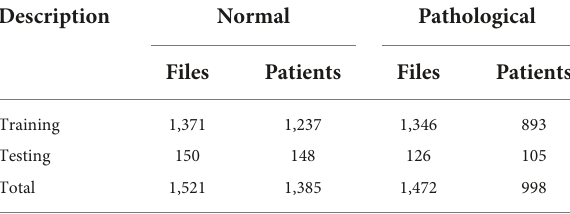
TABLE 1 Number of patients and files in TUH EEG Abnormal Corpus